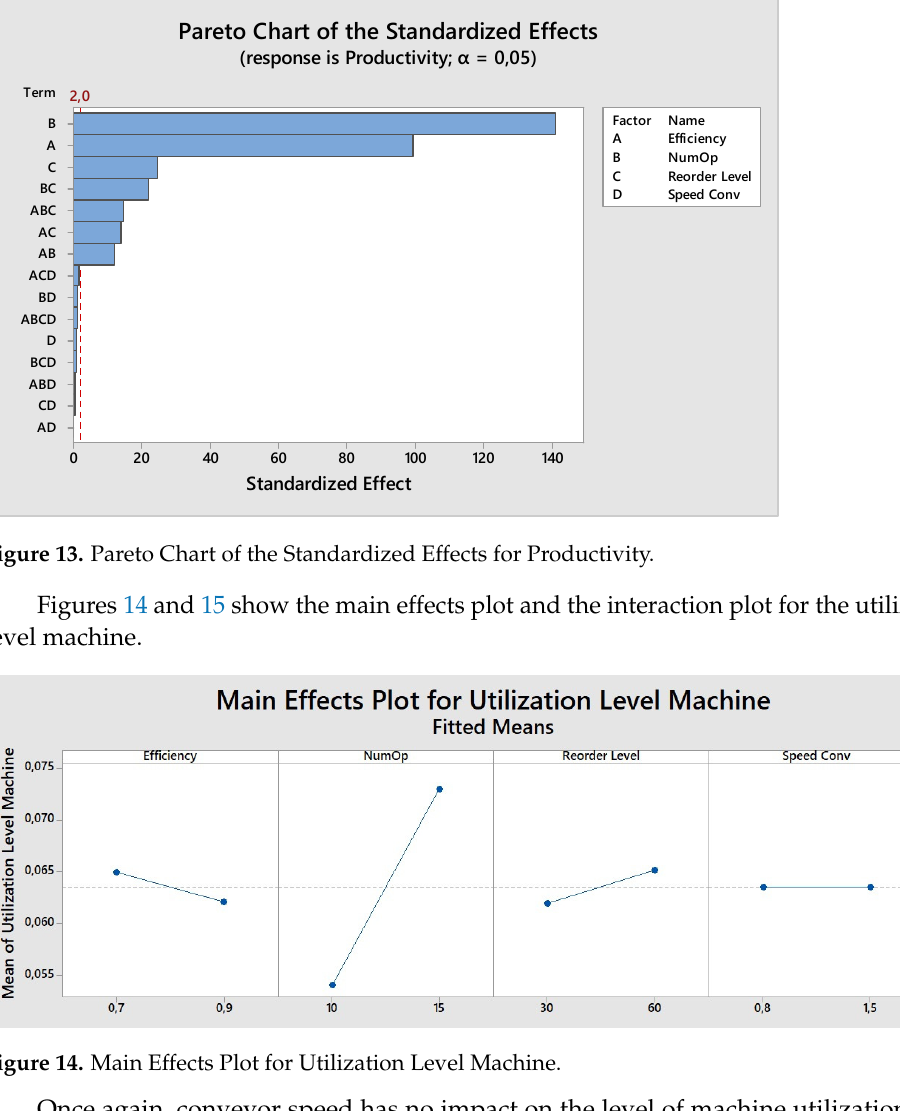
Figure 15. Interaction Plot for Utilization Level Machine. Once again, conveyor speed has no impact on the level of machine utilization. The number of operators has an important influence, followed by the efficiency of the opera- tors and the reorder level. It can be noted that there are interactions between the reorder level and the efficiency, the reorder level and the number of operators, since when they